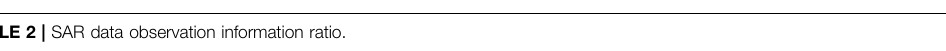
TABLE 2 | SAR data observation information